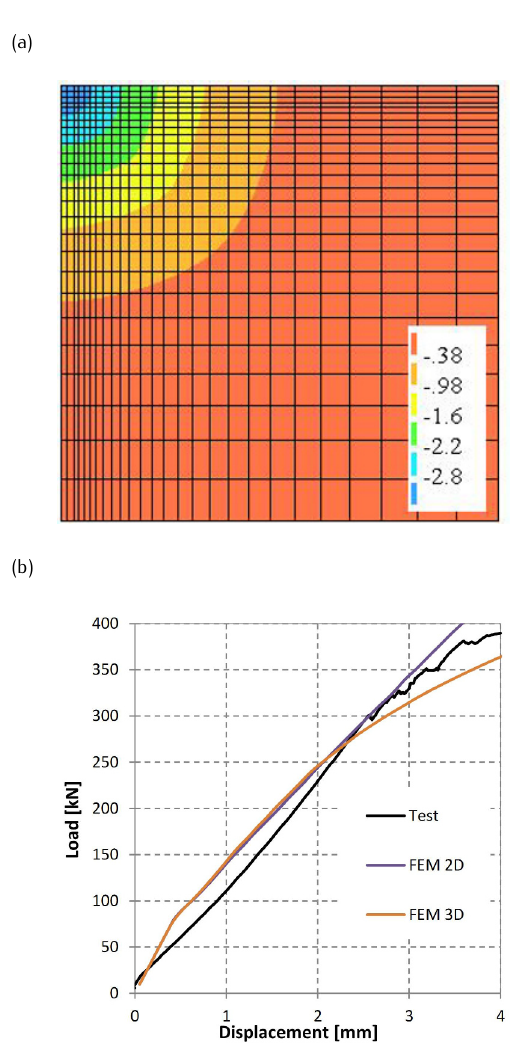
Figure 16. Crack pattern at 380 kN for centre load, (a) Bottom surface, (b) Top surface.